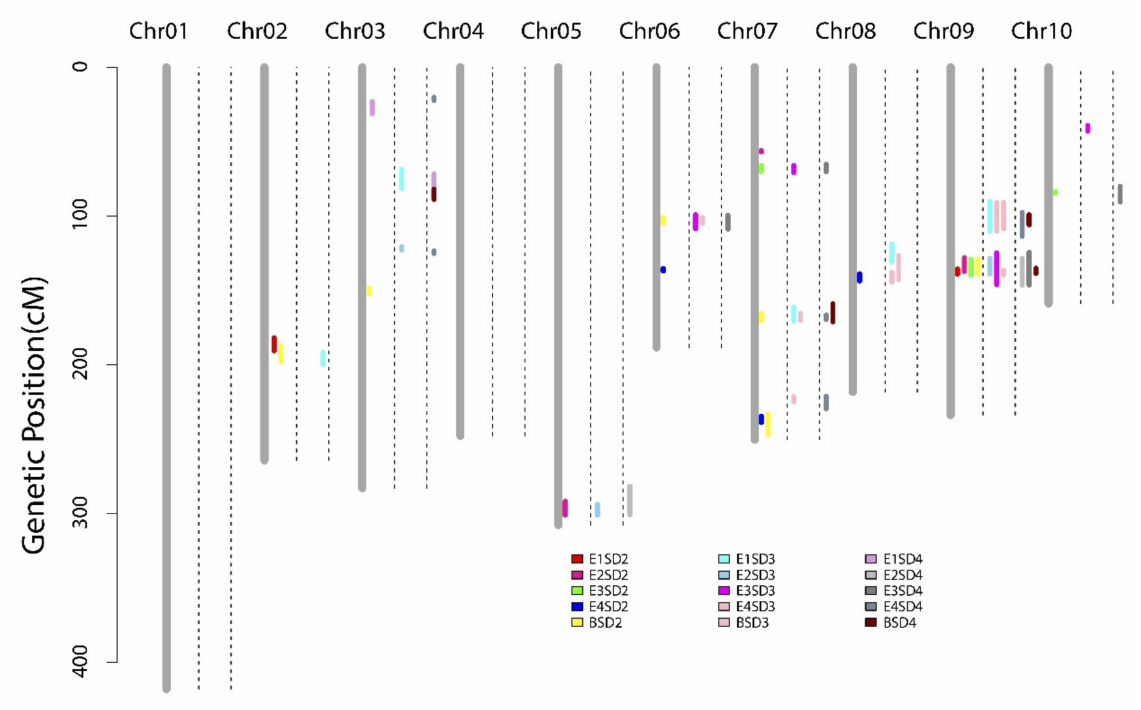
Figure 3. QTL mapping of stalk diameters across four environments and the BLUP model. Colored bars represent QTLs associated with different traits; E1, E2, E3, E4, and B represent the corresponding environment or BLUP model. The two dashed lines next to each chromosome separate the SD-related QTL mapping results for different internodes, SD2, SD3, and SD4, in order. The length of the colored bar indicates the 1.5-LOD QTL support